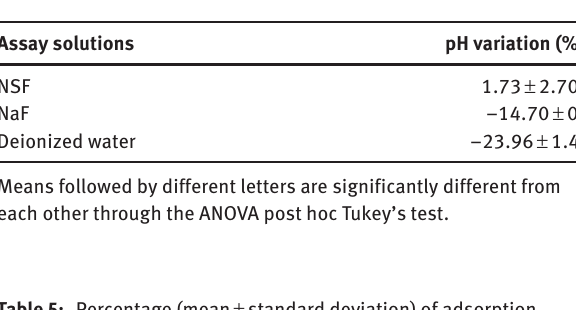
Table 4: Percentage of pH variation (mean ± standard deviation) of the samples treated with test and control solutions.